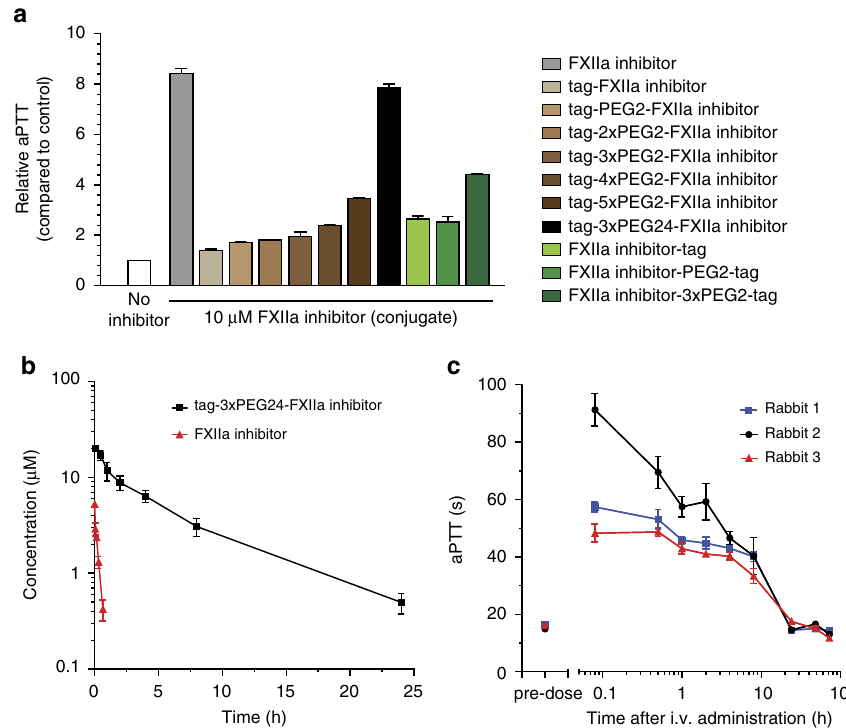
Figure 5 | Inhibition of the intrinsic coagulation pathway with a tag-FXIIa inhibitor conjugate in rabbits. ( a ) aPTT is the time necessary for human plasma to clot upon activation of the intrinsic coagulation pathway. The indicated relative aPTT is the factor by which the coagulation time is prolonged in the presence of 10 m M FXIIa inhibitor or tagged FXIIa inhibitor tested in plasma ex vivo . The tag was conjugated via different linkers to either the N- or C-terminus of the bicyclic peptide FXIIa inhibitor. PEG2 and PEG24 stand for linkers containing two or 24 CH 2 CH 2 O units. ( b ) Study of pharmacokinetics. Concentration of FXIIa inhibitor in rabbit plasma after i.v. administration of 5mgkg (cid:2) 1 tagged FXIIa inhibitor (tag-3xPEG24-FXIIa inhibitor) or 3.7mgkg (cid:2) 1 FXIIa inhibitor ( n ¼ 3). s.d.’s are indicated. ( c ) aPTT in rabbit plasma samples taken before and after i.v. administration of 5mgkg (cid:2)